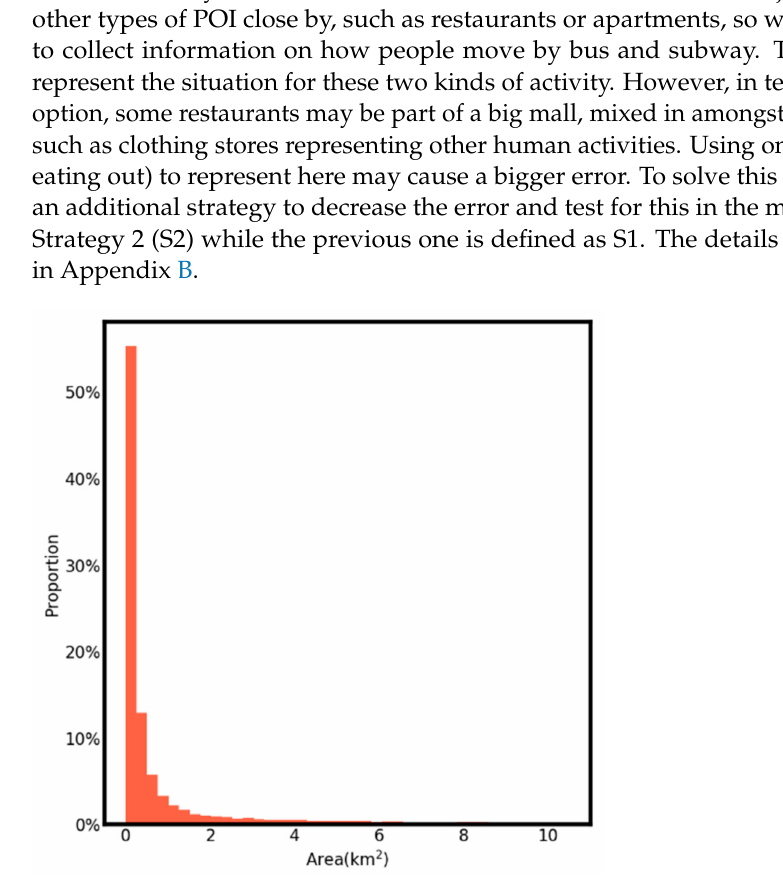
Figure A2. Areas proportion distribution of base station